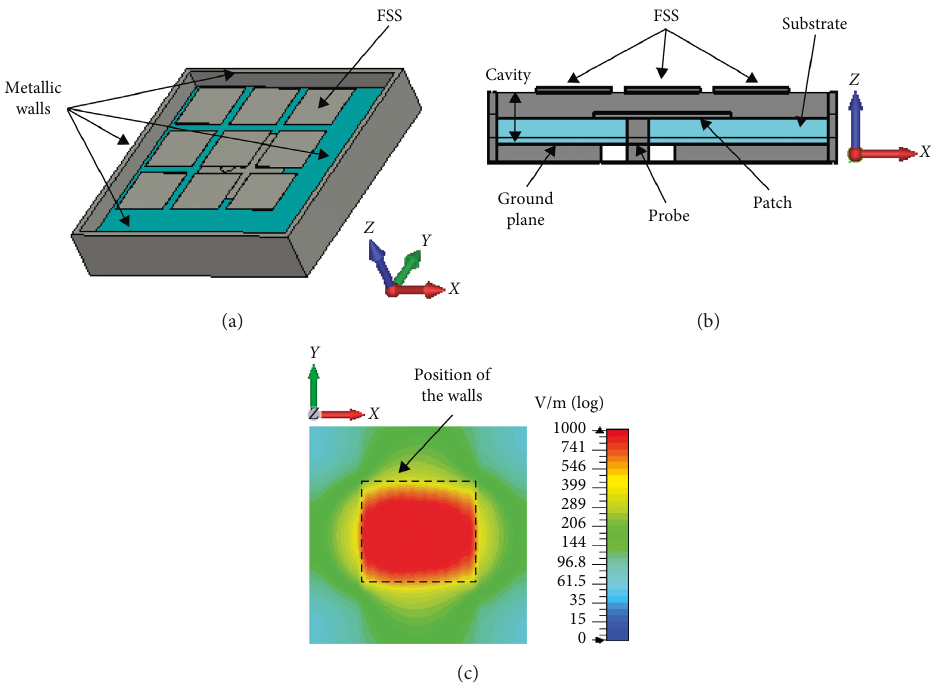
Figure 3: Pixel antenna fed by a patch. (a) Perspective view. (b) Cut view along X -axis. (c) E-field cartography in the top plane. 0, 8